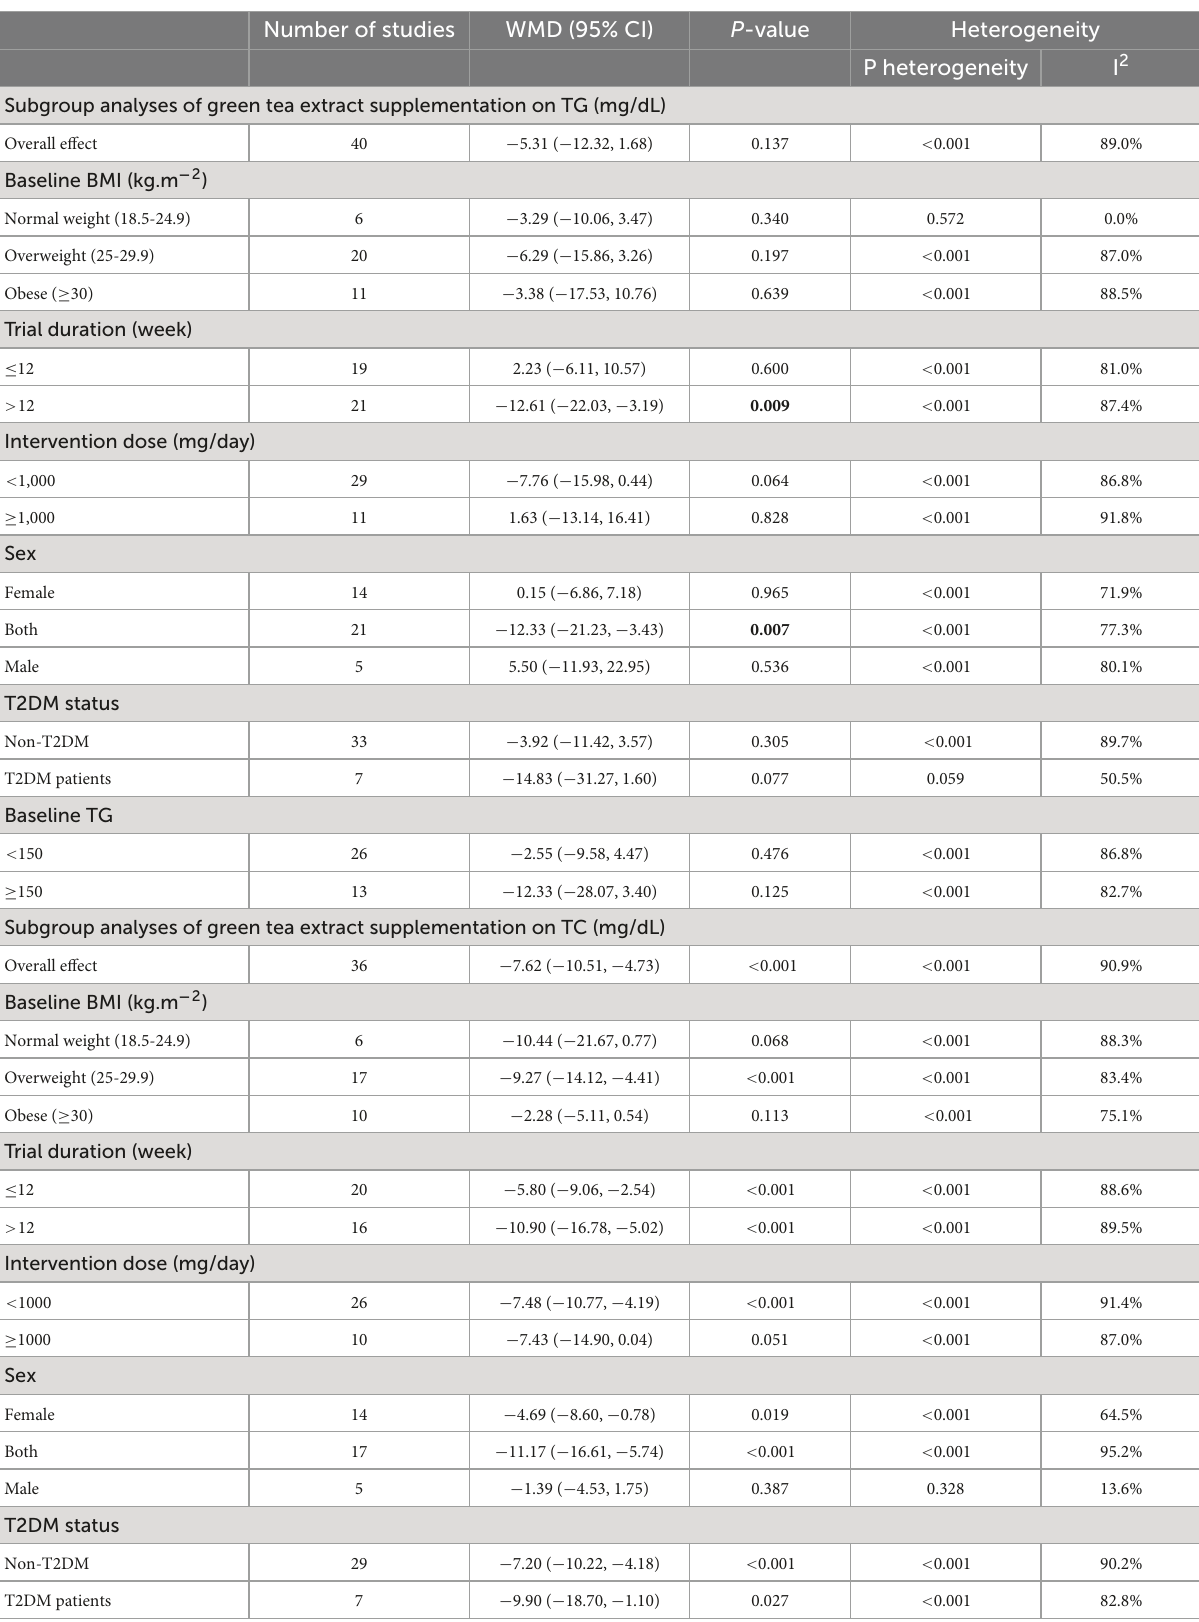
TABLE 3 Subgroup analyses of green tea extract supplementation on some cardiovascular risk factors in adults. Number of studies WMD (95% CI) P -value Heterogeneity P heterogeneity I